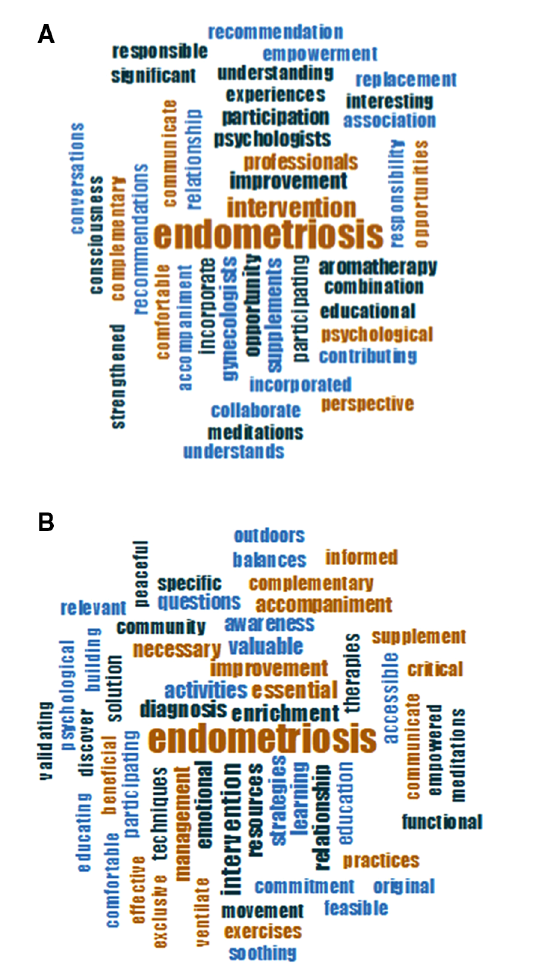
FIGURE 5 Word clouds representing the most common words used to describe the subjects ’ experience during the EE intervention. Transcripts from support group discussion that took place 3 months after the end of the intervention were analyzed using NVivo. Perceived bene fi ts of the EE intervention are shown in panel A . Perceived value of the EE intervention for the management of endometriosis symptoms is shown in panel B